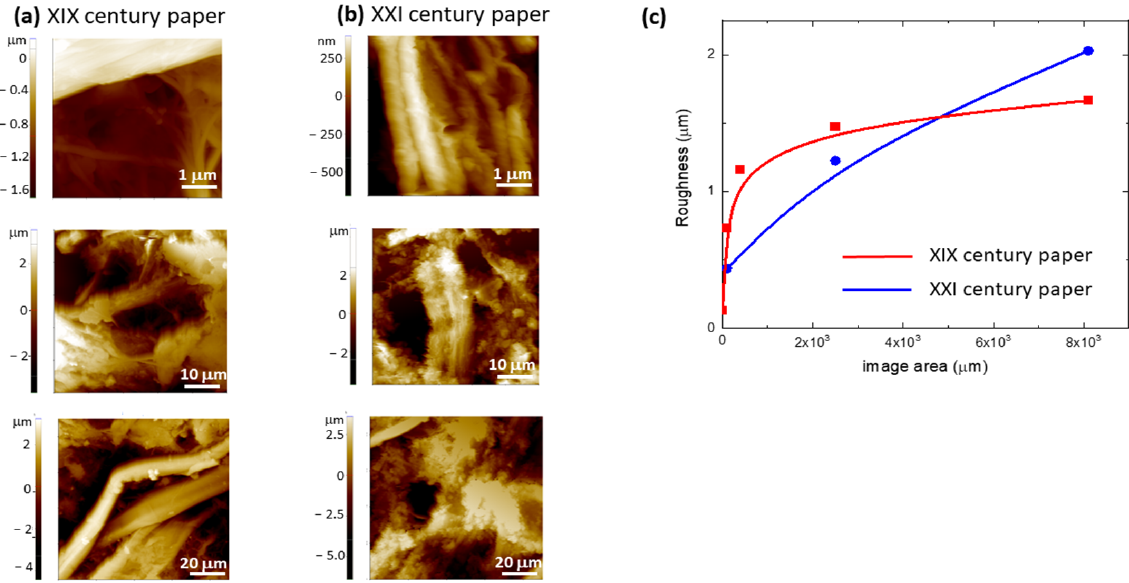
Figure 7. AFM images acquired on ( a ) XIX and ( b ) XXI century paper by scanning areas of different size. ( c ) Values of the local roughness calculated as standard deviation from the average value of the height histogram built on each area for XIX and XXI century paper.